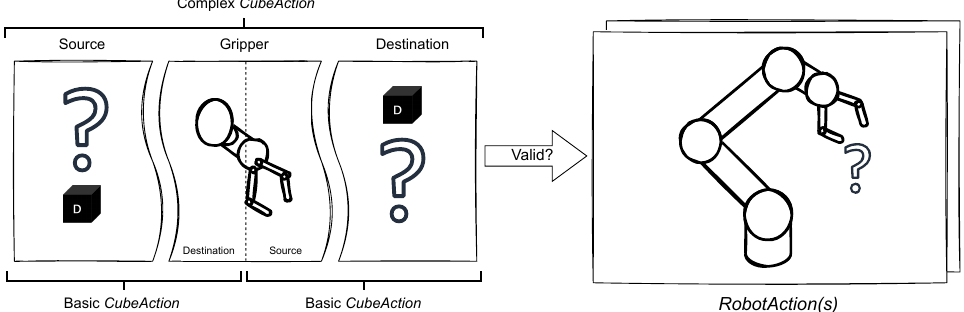
Figure 9. CubeAction can be simple or complex, corresponding to multiple RobotActions